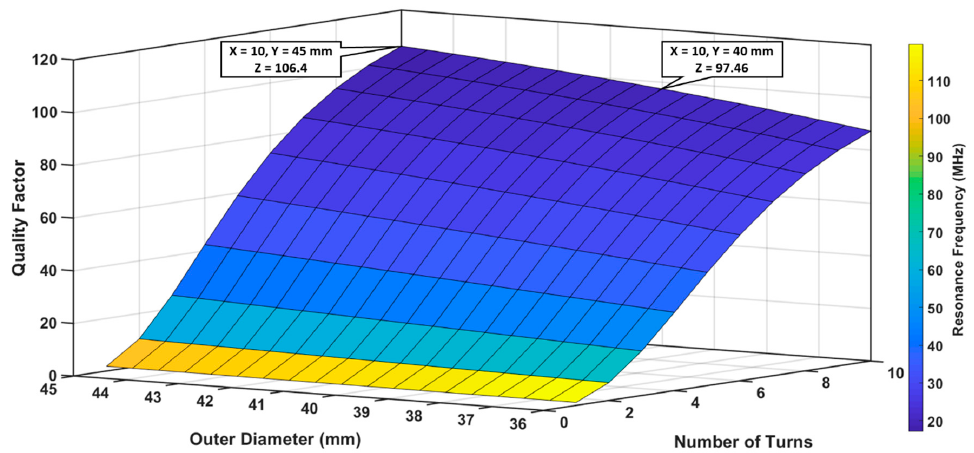
Figure 6. Analysis of S 1 quality factor and resonance frequency for different number of turns and outer diameters, when trace separation and width were kept constant at 500 μ m.